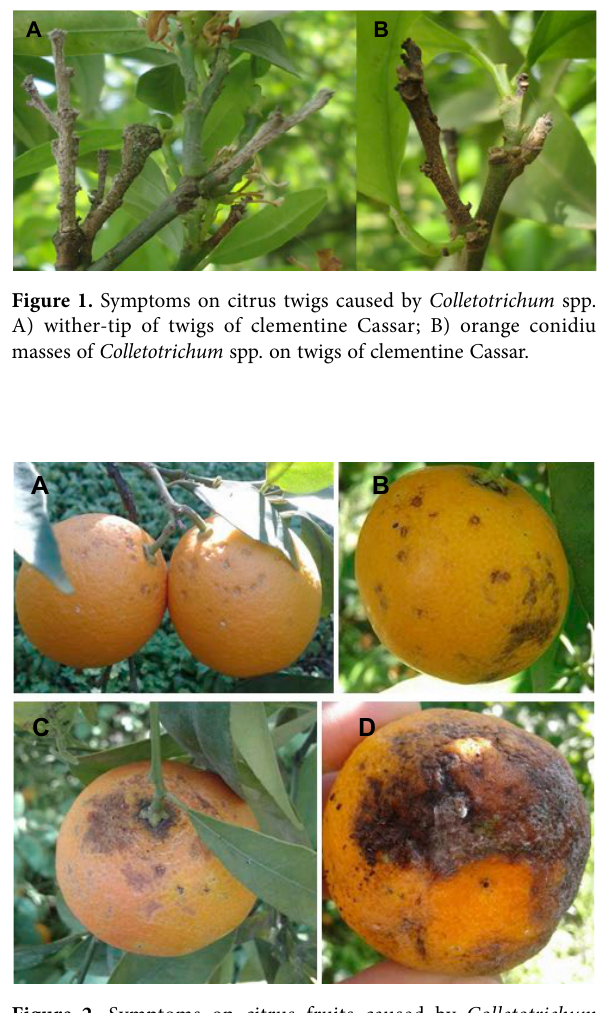
Figure 2. Symptoms on citrus fruits caused by Colletotrichum spp. A) Brown and dark lesions on orange, and B) on clementine. C) Stem-end rot on clementine. D) Typical anthracnose on fallen clementine fruit.